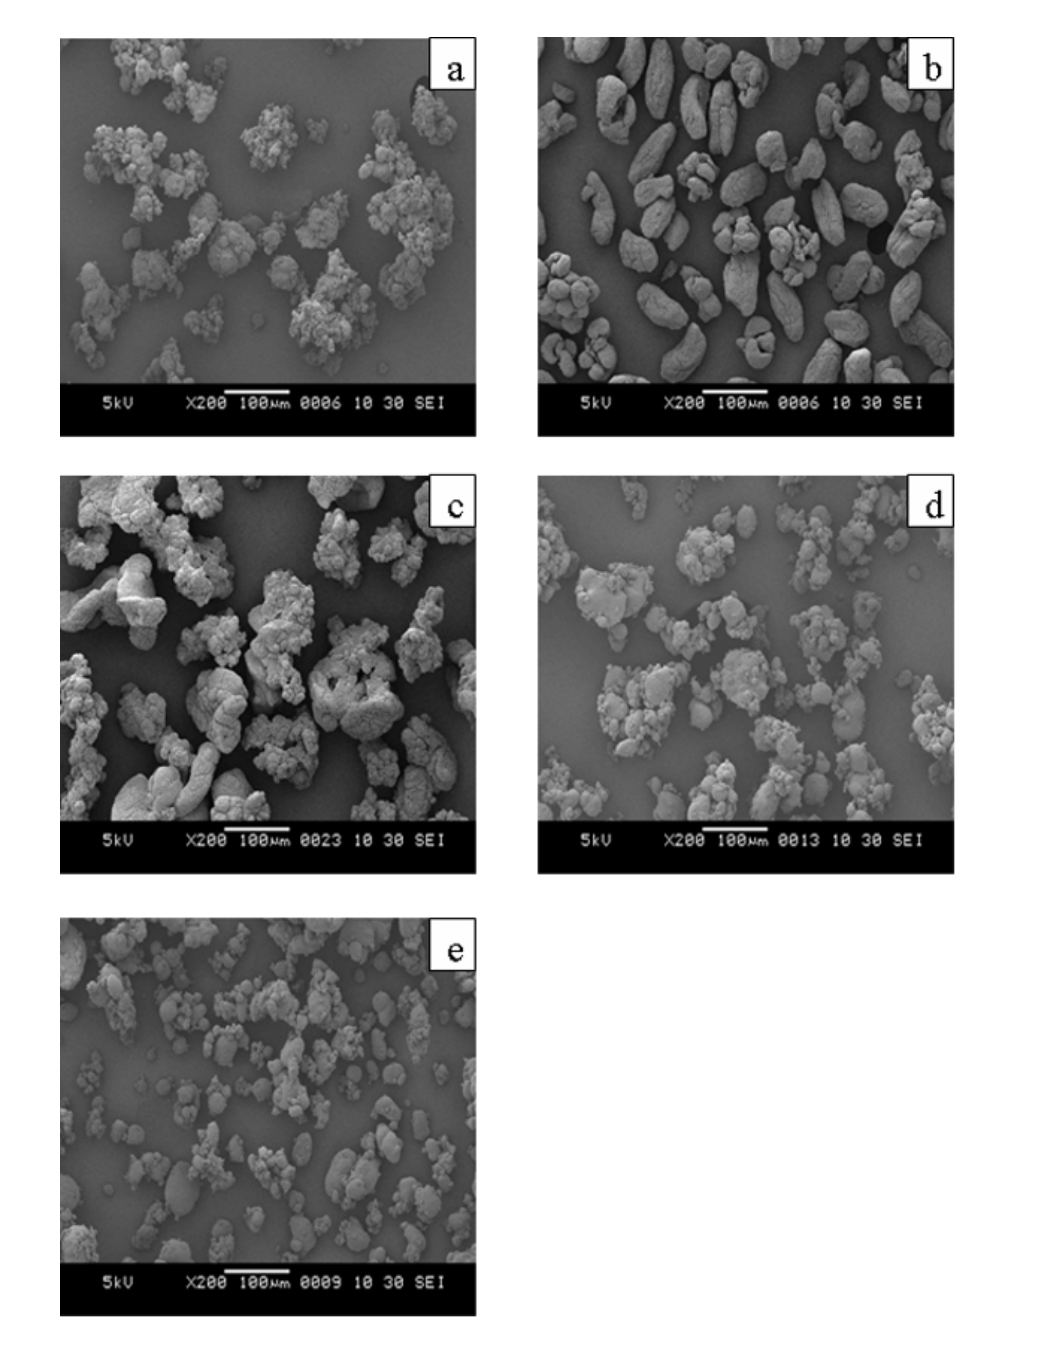
Figure 6. SEM micrographs of secondary product particles obtained with different activators; (a) TEA, (b) DEAC, (c) TnHA, (d) TEA+DEAC, (e)